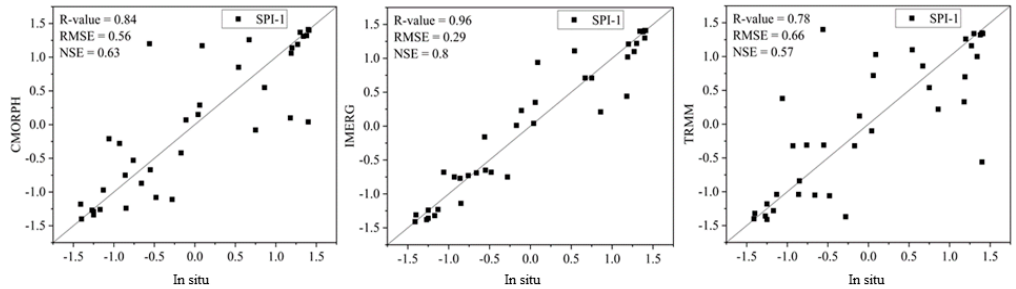
Figure 7. Comparison of the one-month standardized precipitation index (SPI-1) calculated from the satellite-based precipitation products and in situ observations.